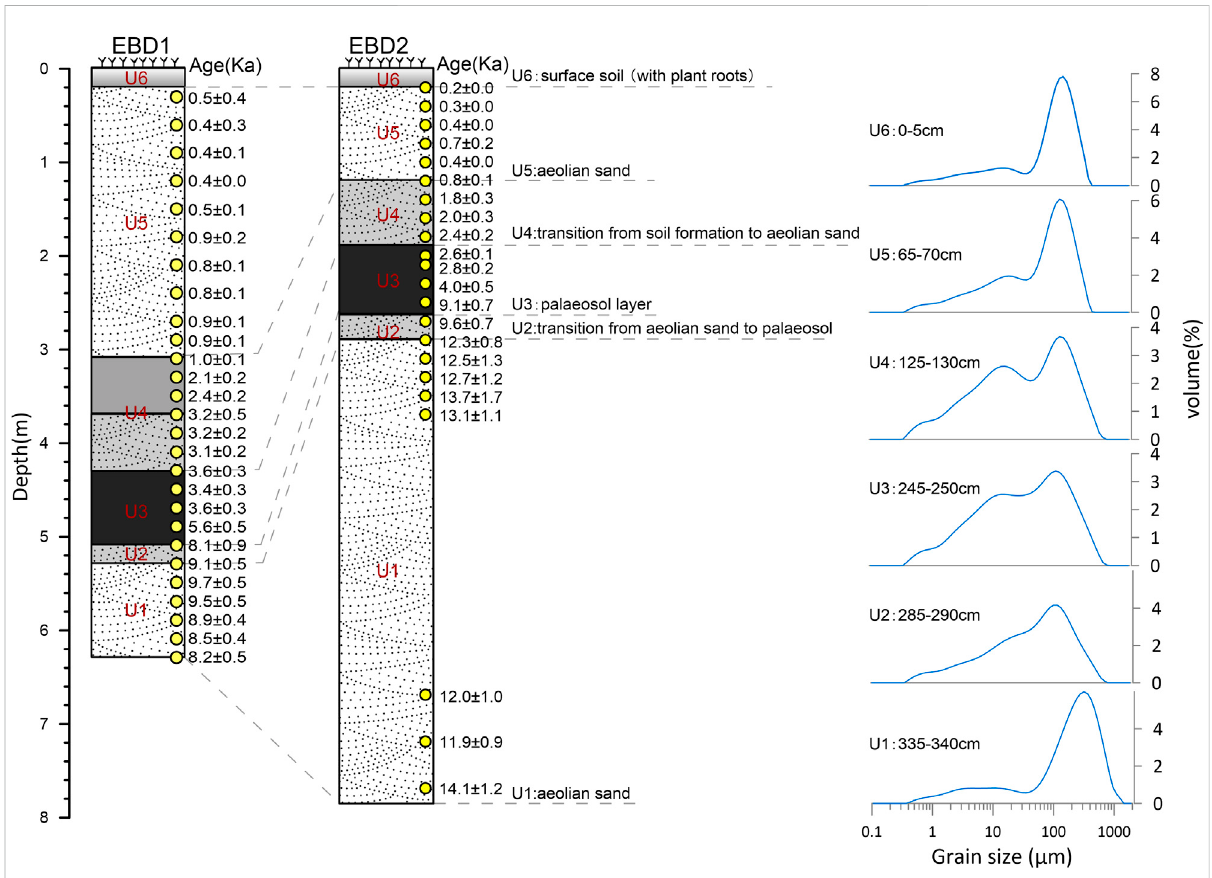
FIGURE 3 Stratigraphy and chronology of the EBD1 and EBD2 sections and typical grain size distribution frequency curves of each of six